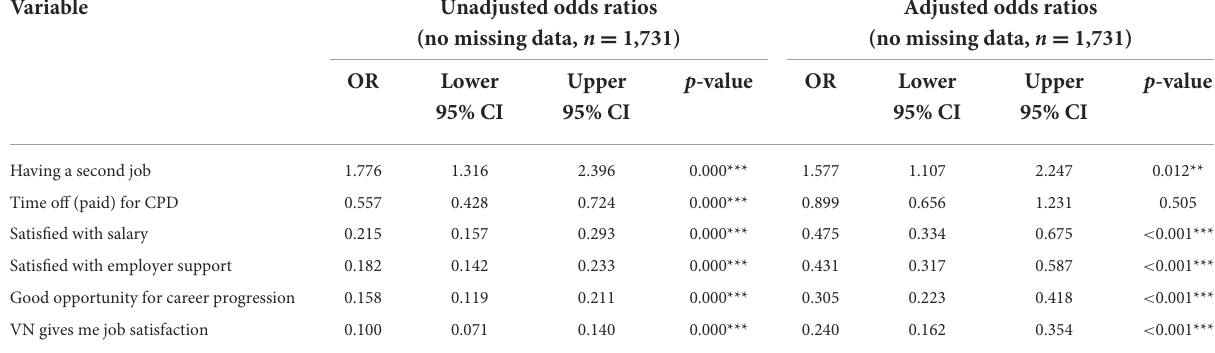
TABLE 4 2019 Unadjusted and adjusted odds ratios.